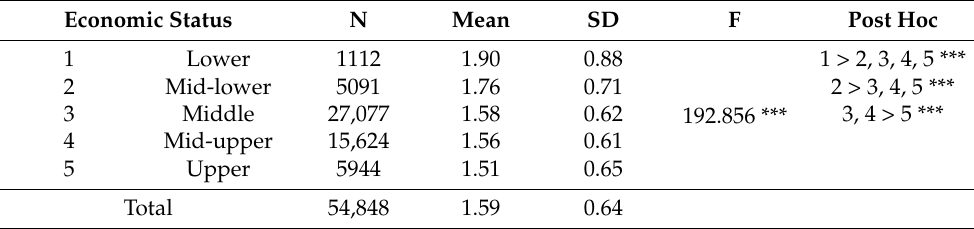
Table 5. Comparison of mean GAD scores by economic